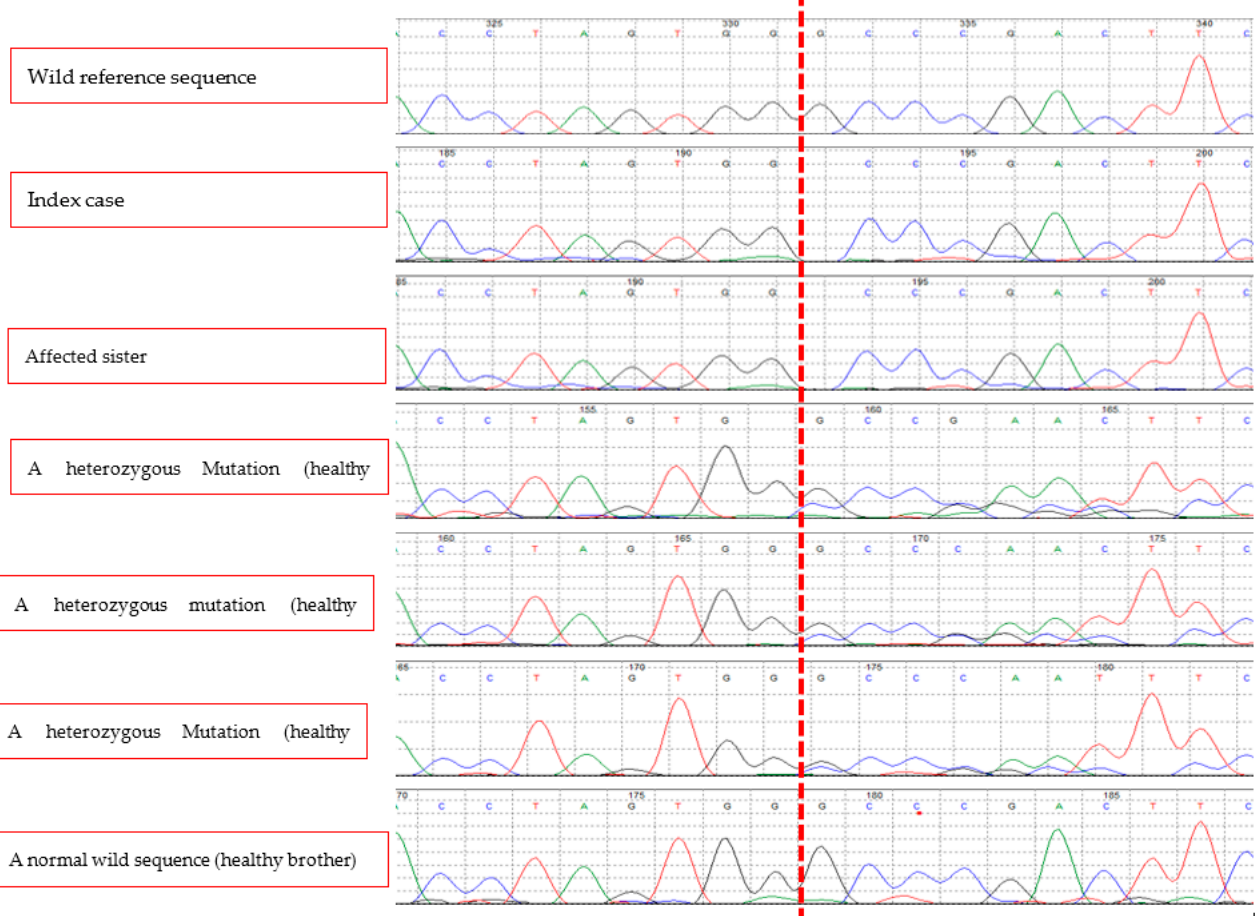
Figure 3. A biallelic deletion mutation (c.387delG, p.Asp131ThrsTer116) in exon 2 of SOST gene of the index case. Her affected sister has the same mutation while two of her unaffected brothers and her mother have the same mutation in a monoallelic form. One healthy brother has a normal sequence. The vertical red dashed line indicates the location of the deleted nucleotide (G) in homozygous form in the two affected sisters, in a homozygous form in the unaffected carriers, and a normal sequence in the healthy brother.